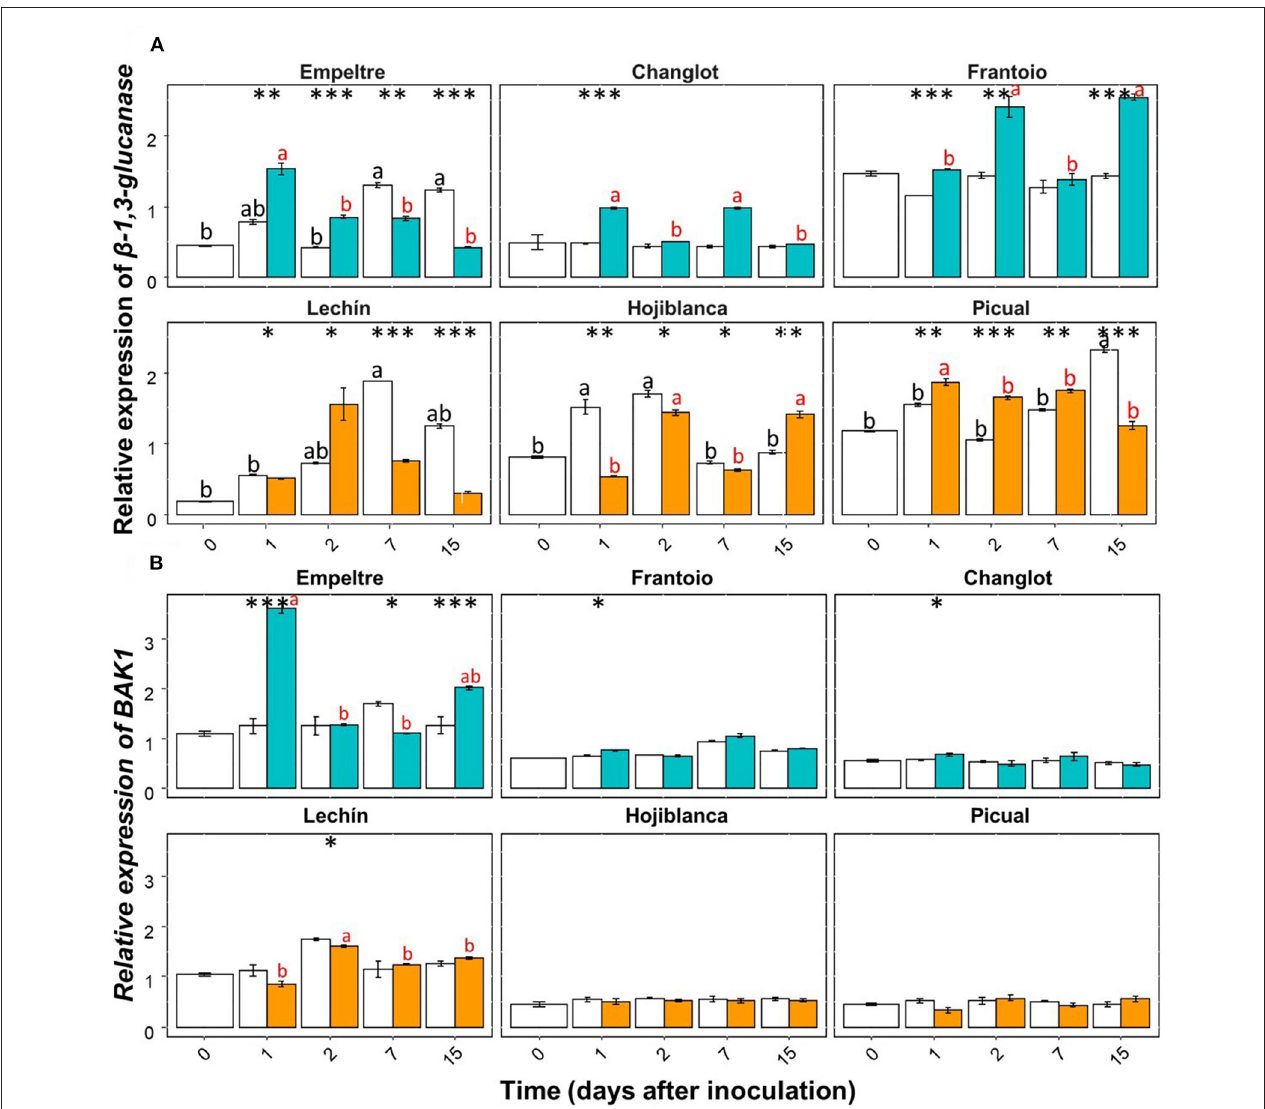
FIGURE 4 | Time course of the relative expression of the β -1,3 glucanase (A) , and BAK1 (B) genes. Control (non-inoculated) plants are represented in white color while Verticillium dahliae -inoculated plants are shown in light blue color (tolerant cultivars) or in orange color (susceptible varieties). The error bar corresponds to the standard deviation (SD) from the mean of the three biological replicates. Tukey’s post hoc test differences ( p < 0.05) are represented in black letters among the control plants and in red letters among inoculated plants. The statistical differences resulted by the ANOVA analysis between the control and inoculated plants are represented by asterisks (level of significance: *, p < 0.05; **, p < 0.01; ***, p <